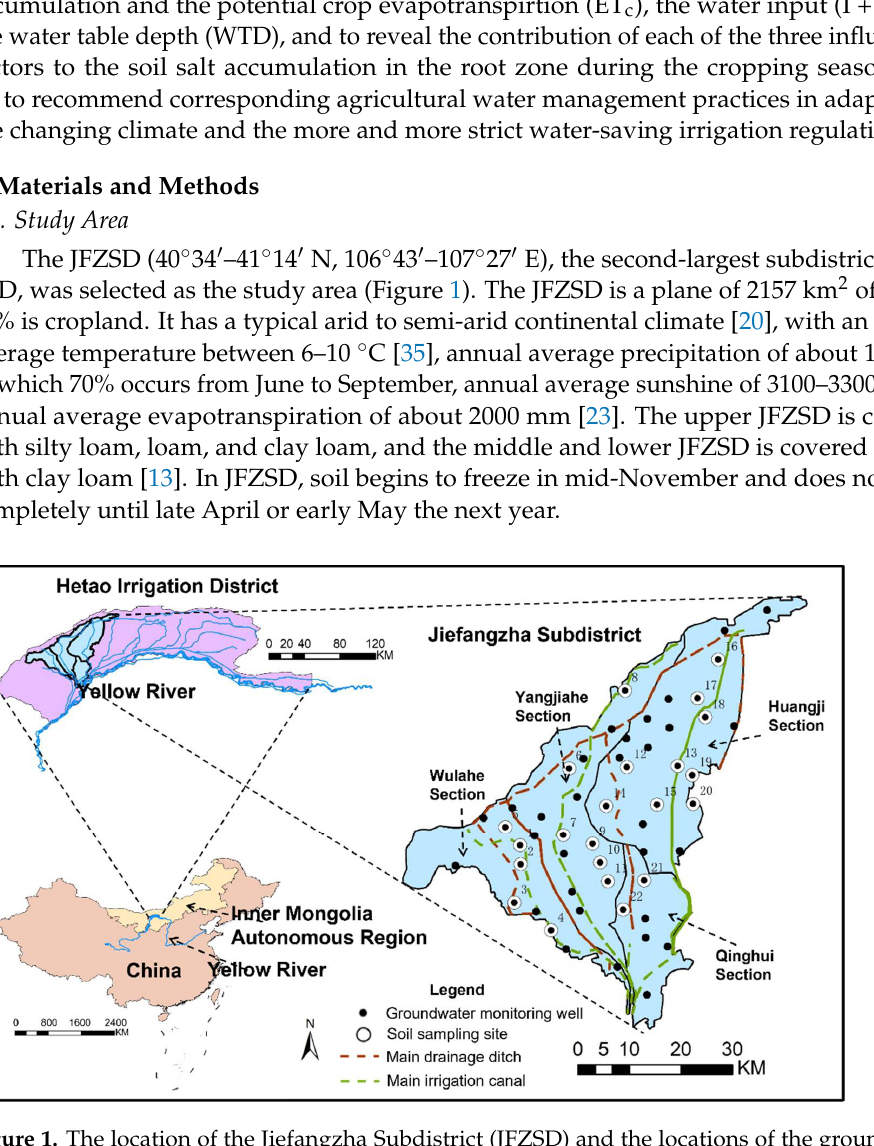
Figure 1. The location of the Jiefangzha Subdistrict (JFZSD) and the locations of the groundwater monitoring wells and soil sampling sites.